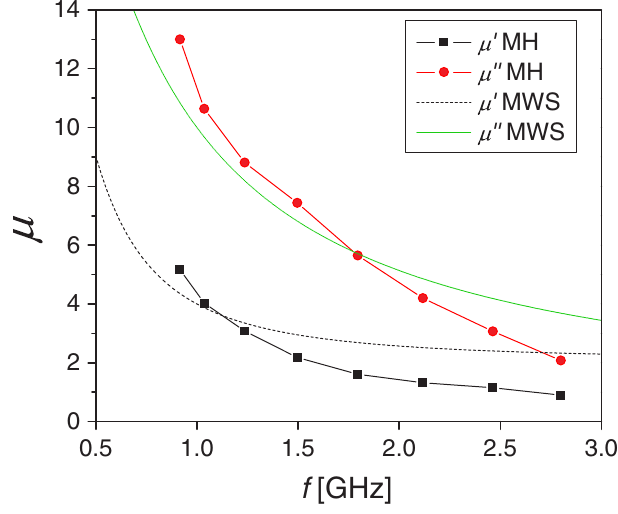
FIG. 7. (Color) Comparison of ferrite permeability (cid:3) (cid:4) 4 ð 1 (cid:1) j 2 : 5 Þ used in the MWS simulations with MH results.